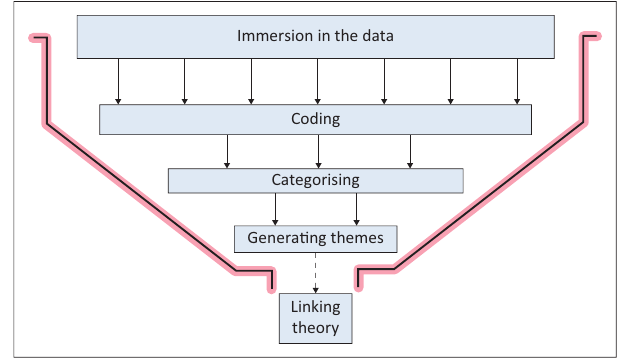
FIGURE 1: Steps in qualitative data analysis using thematic